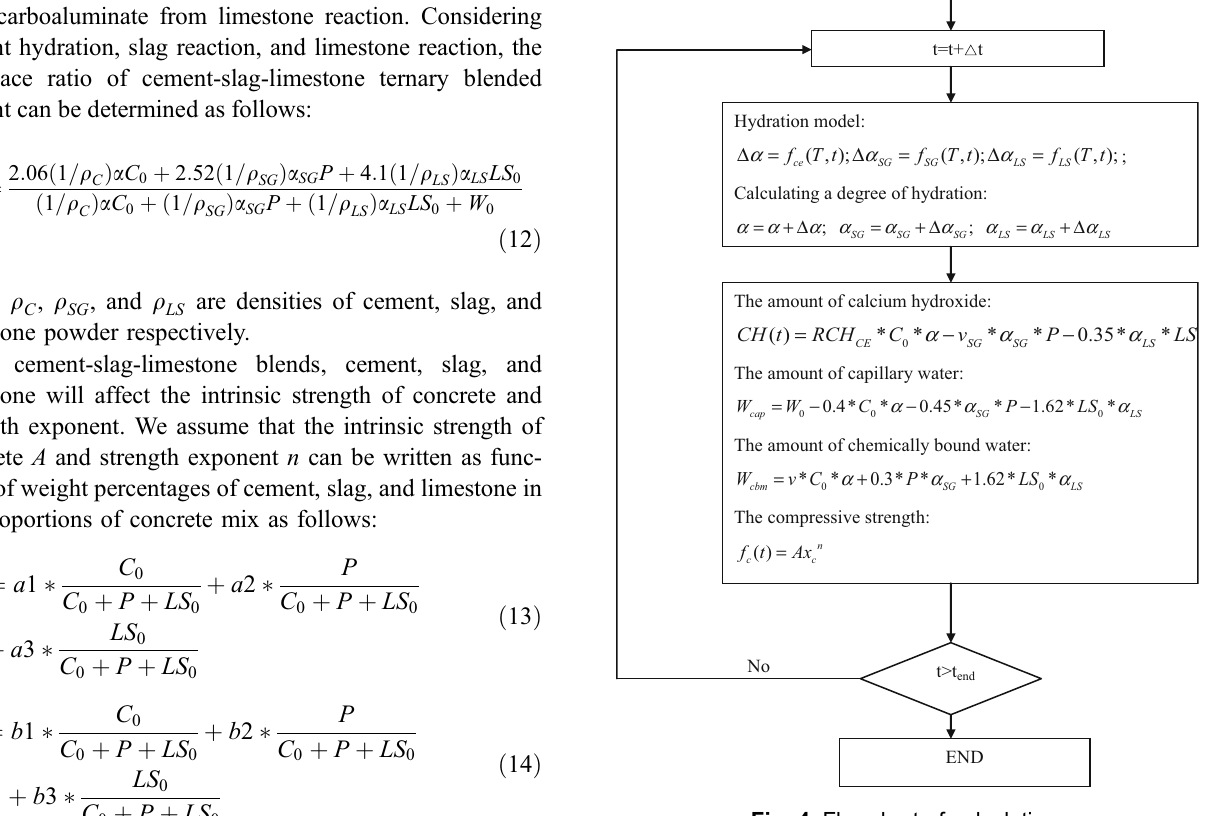
Fig. 4 Flowchart of